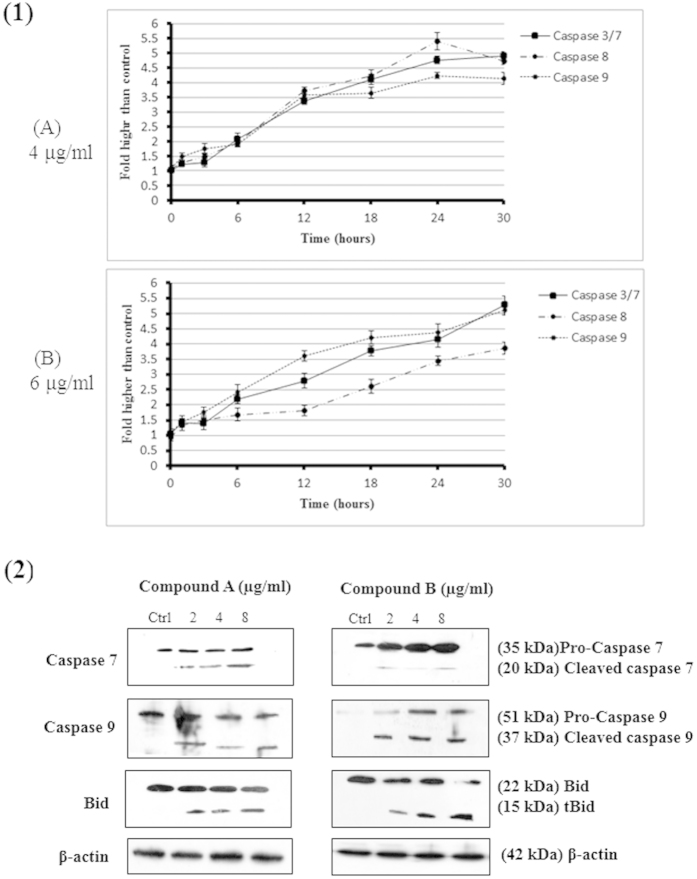
(1) Relative luminescence time-dependent expression of caspases 3/7, -8 and -9.MCF-7 cells treated with A and B at concentrations of 4 and 6 μg/mL, respectively, after 24 hours of incubation showed significant expression of caspases 3/7, -8 and -9. (2) Western blot analysis of A- and B-treated MCF-7 cells. Cells were treated with compounds for 24 hours before being lysed and subjected to separation by sodium dodecyl sulfate polyacrylamide gel electrophoresis. Proteins were then transferred to a membrane and probed with antibodies against caspase 7, -9 and Bid. The membrane was reprobed with anti-β-actin antibody as the loading control. The band densities of treated samples were normalized to the control. The results revealed significant activation of caspases -7, -9 and Bid.